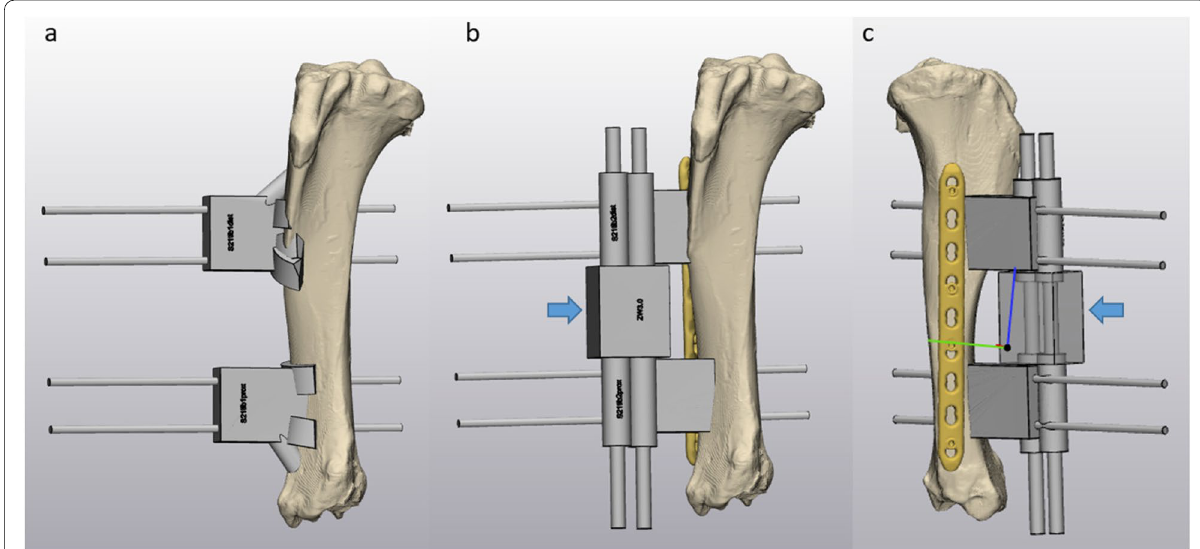
Fig. 2 Tibial surgical guide planning with Materialise 3-matic software. a shows the first step guides with additional “feet” to allow proper bone contact and high accuracy in anterolateral view. Drill pins are inserted through these guides and define the fragment in space. Second step connection guides were slimmer and allowed plate placement, as displayed anterolateral view ( b ) and medial view ( c ). To connect the proximal and distal second step guide, a reduction/connection guide was used in-between (blue